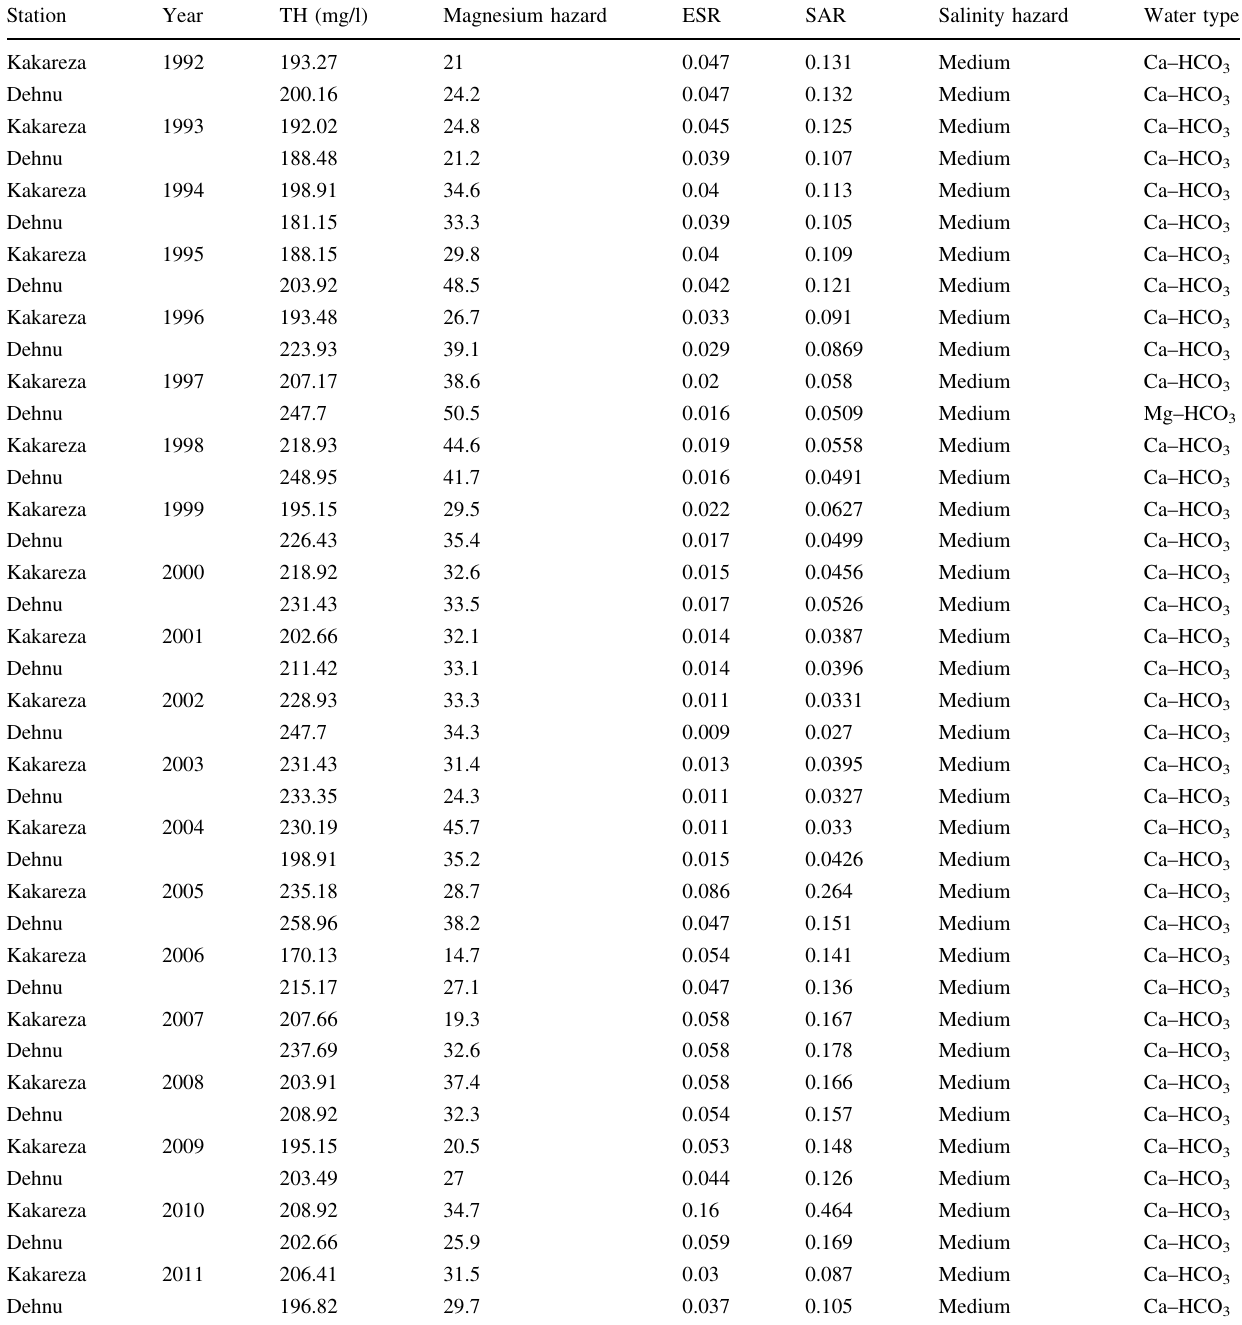
Table 6 Calculated parameters with Aq.QA